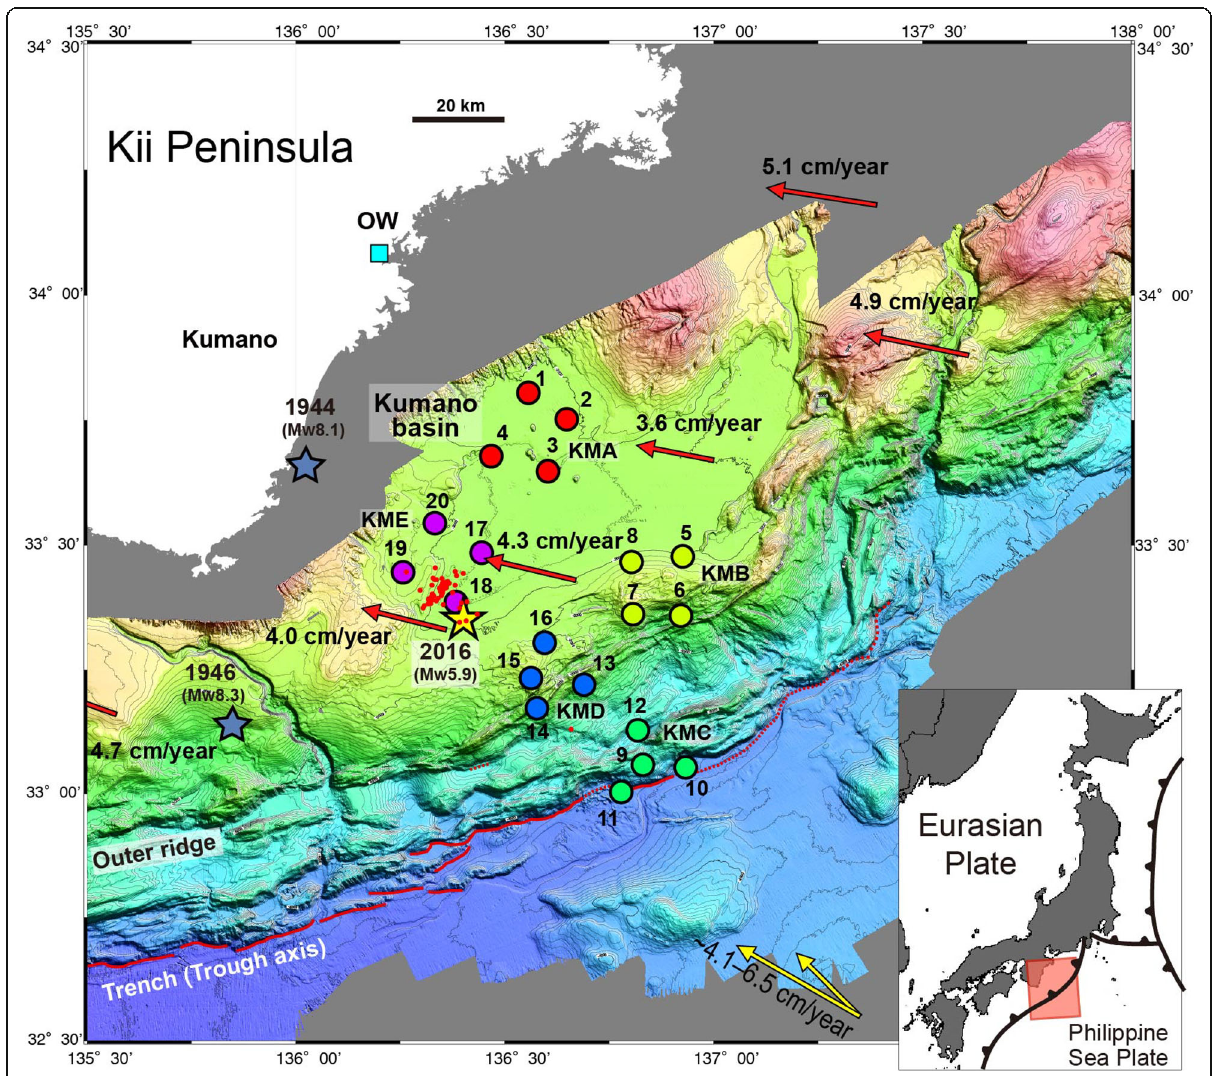
Fig. 1 Tectonic, bathymetric, and geologic features of the Nankai trough region (after Tsuji et al. 2017). Circles represent DONET stations with different colors for each node (KMA, KMB, KMC, KMD, and KME), and the square represents the OW tidal gauge station. The yellow star is the epicenter of the 2016 Off-Mie earthquake, and the red dots represent epicenters of foreshocks and aftershocks from 3 h before to 48 h after the mainshock (Wallace et al. 2016). Blue stars represent the epicenters of the 1944 Tonankai and the 1946 Nankaido earthquakes. Red arrows represent seafloor velocity vectors from Yokota et al.